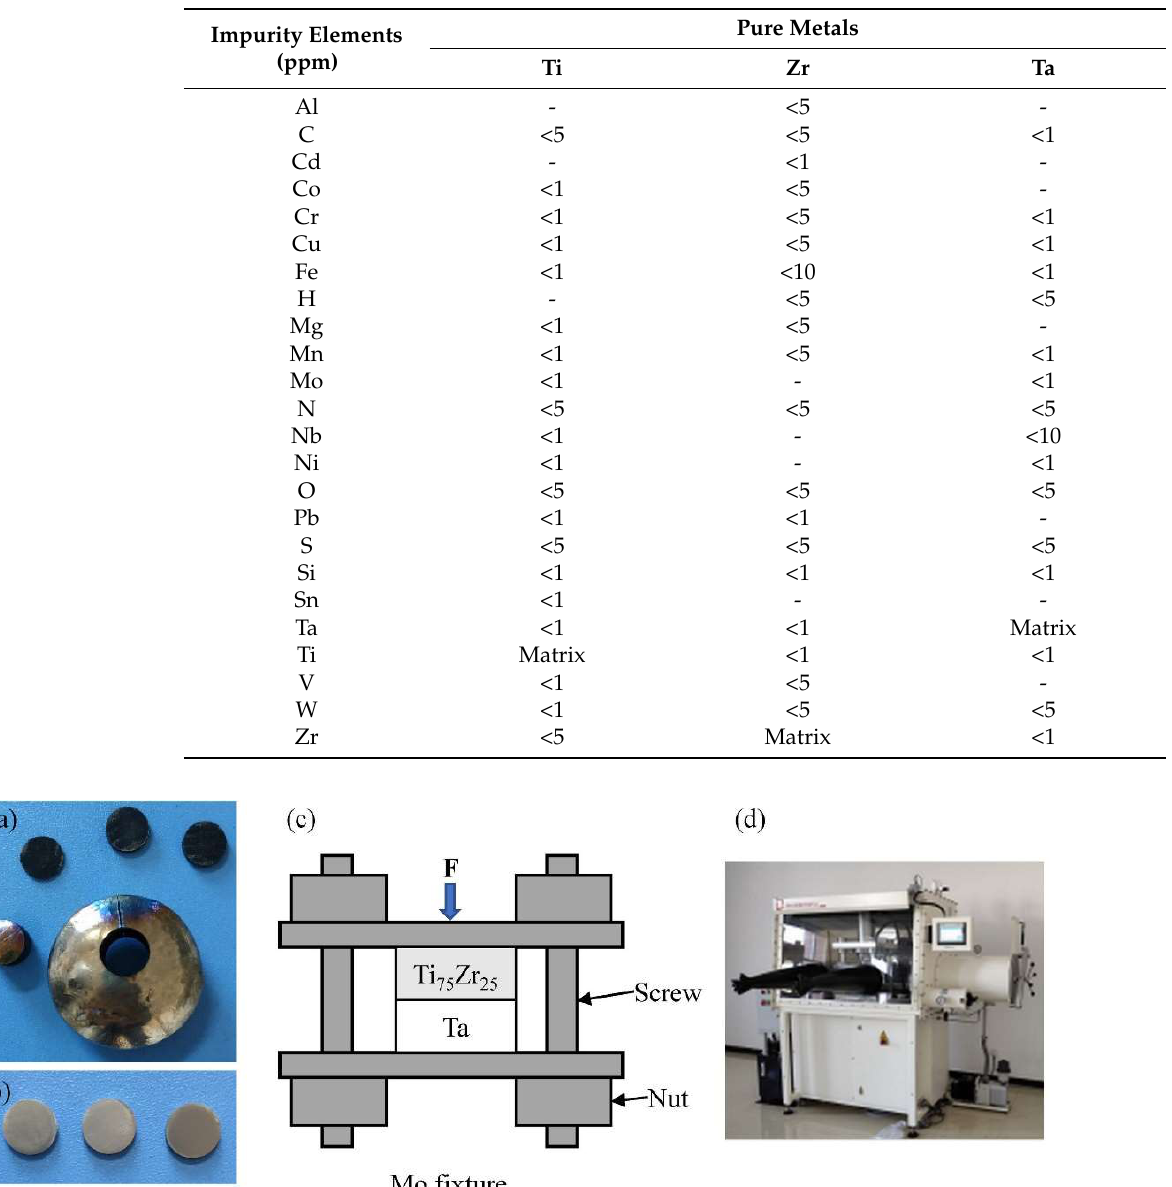
Figure 1. Specimens and assembly pictures: ( a ) ingots; ( b ) diffusion specimens; ( c ) assembly diagram; and ( d ) a vacuum glove box with a press.